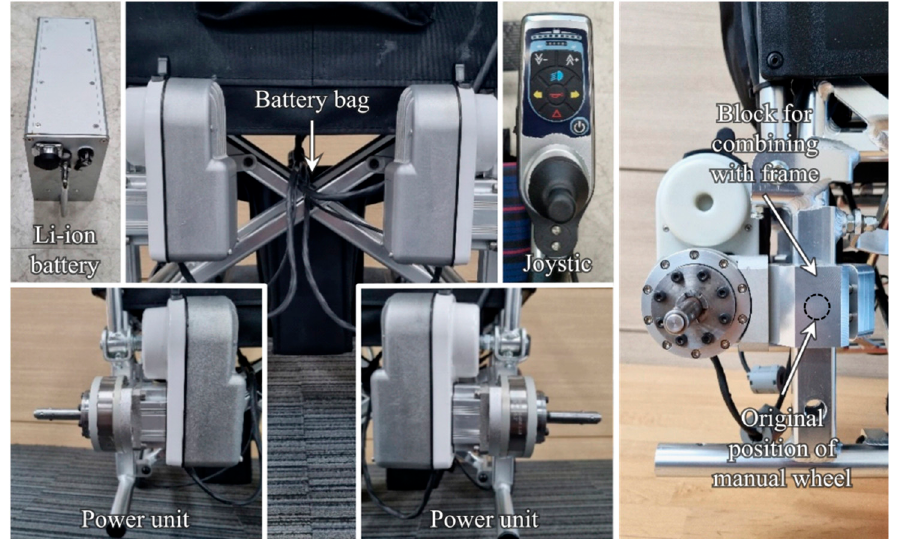
Figure 9. Composition of the power-assist device.